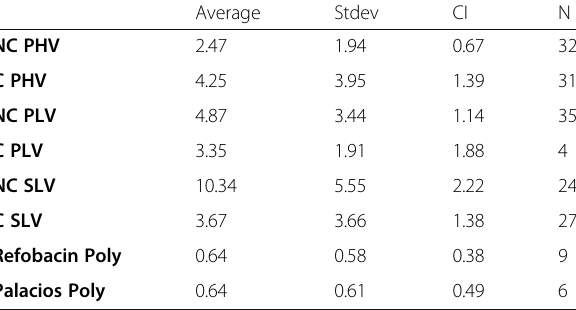
Table 1 Distribution of testing samples utilizing different cement brands of both high and low viscosity's tested on coated and non-coated tibial trays Average Stdev CI